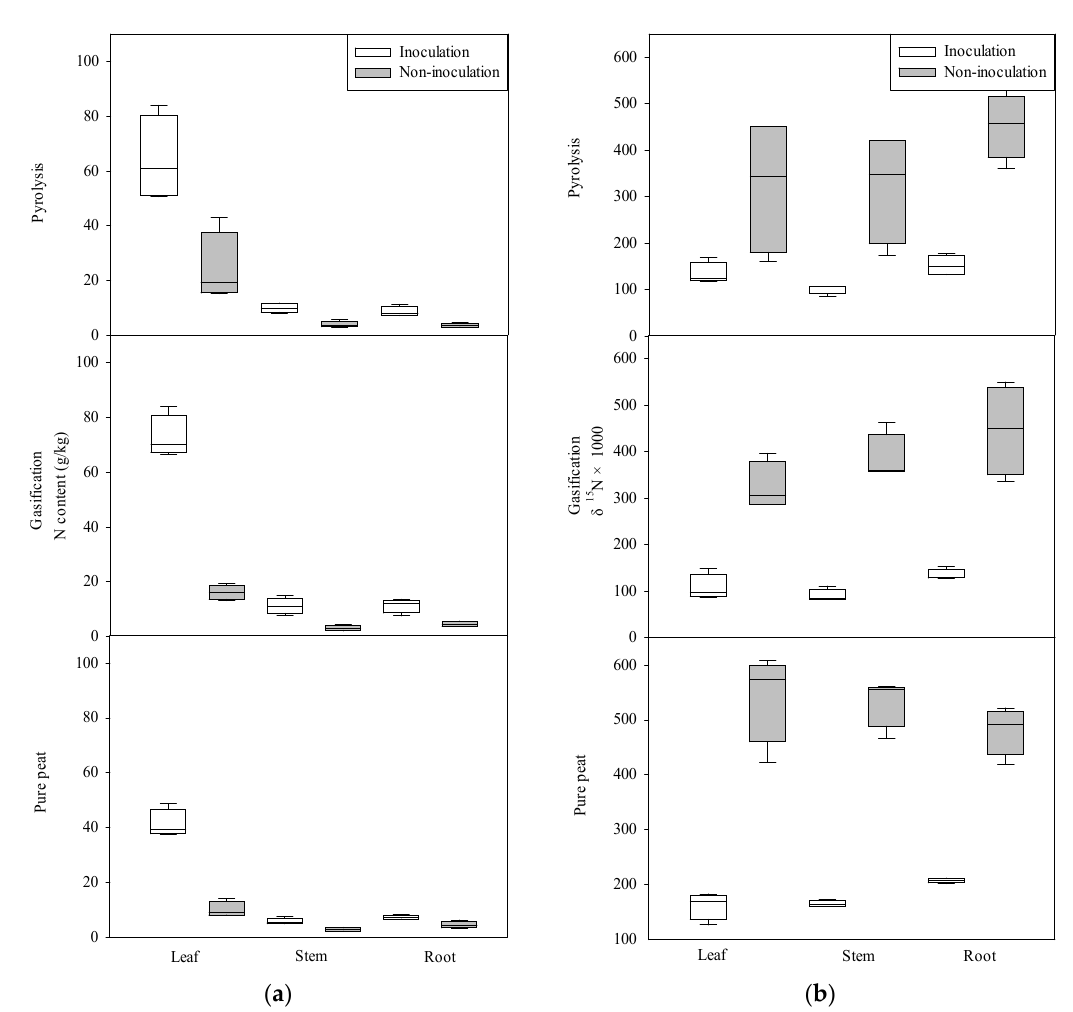
Figure 2. Nitrogen content ( a ) and stable nitrogen isotope ratio ( δ 15 N × 1000) ( b ) in different tissue types of black locust seedlings for 2 types of biochar and a control and 2 levels of rhizobia inoculation.